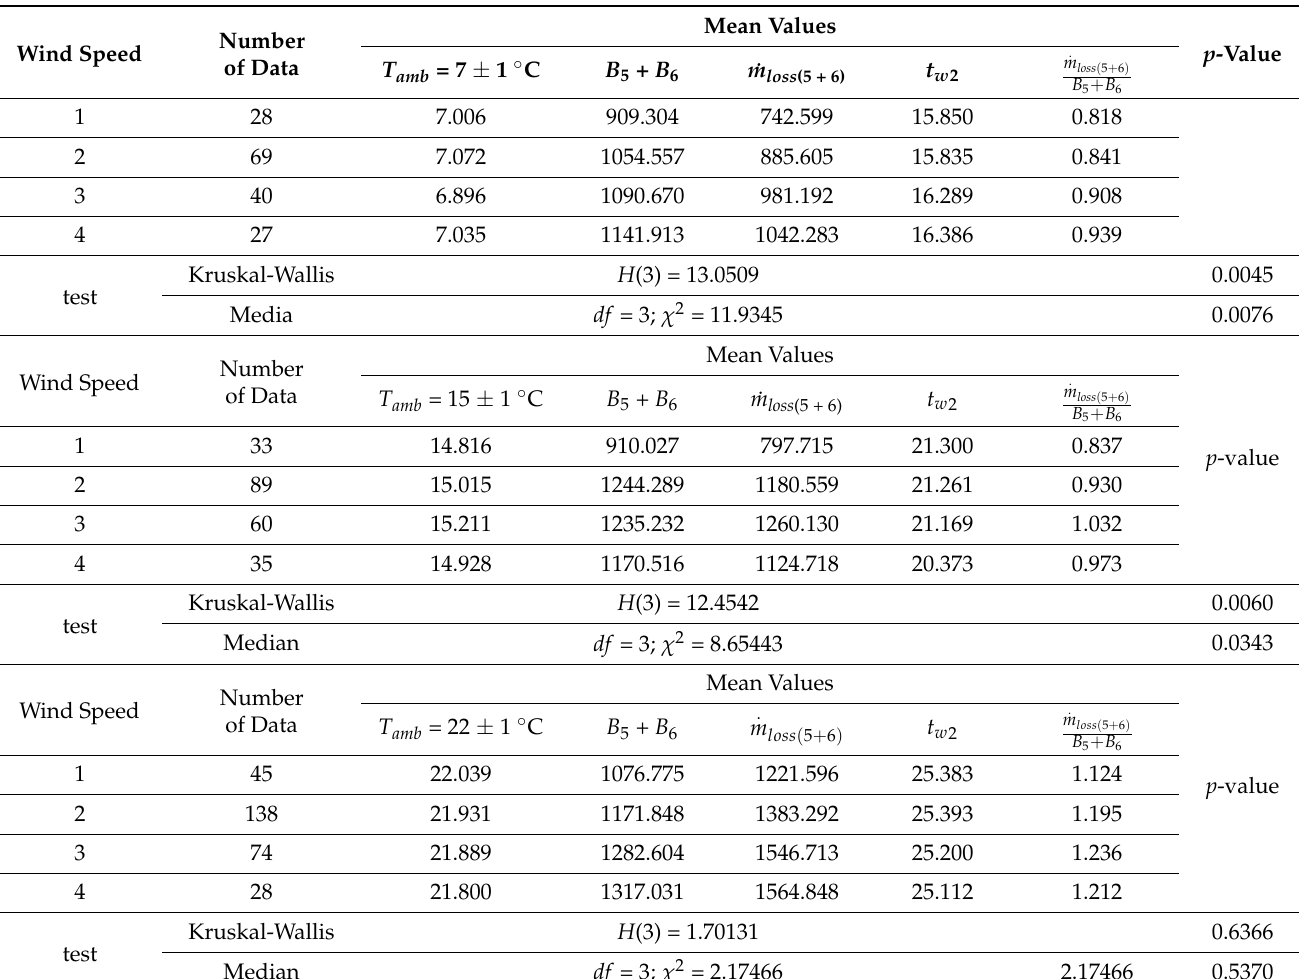
Table 1. Mean values of selected parameters presented on Figure 8a–c and Kruskal-Wallis test statistic values and median test for values